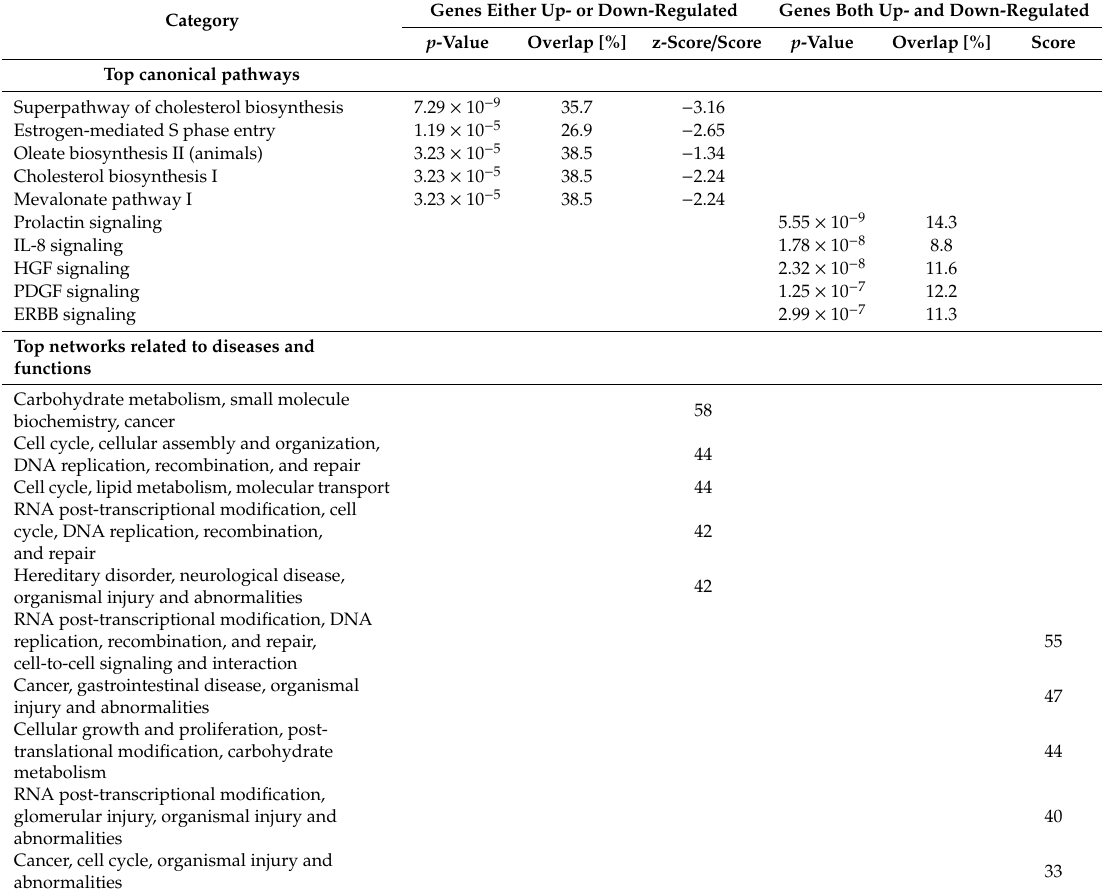
Table 2. Top pathways and networks in MTF-treated vs. MTF-untreated